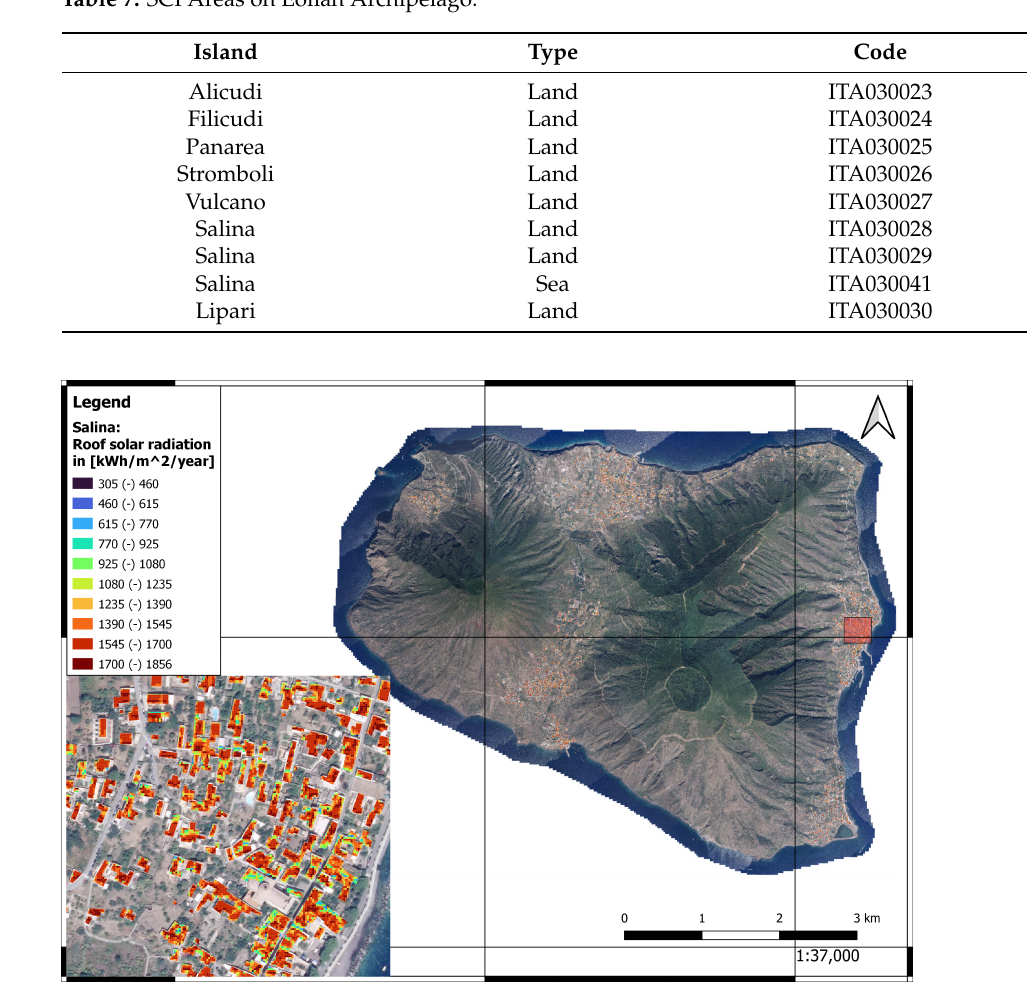
Figure 24. Solar Radiation of the roofs of Santa Marina